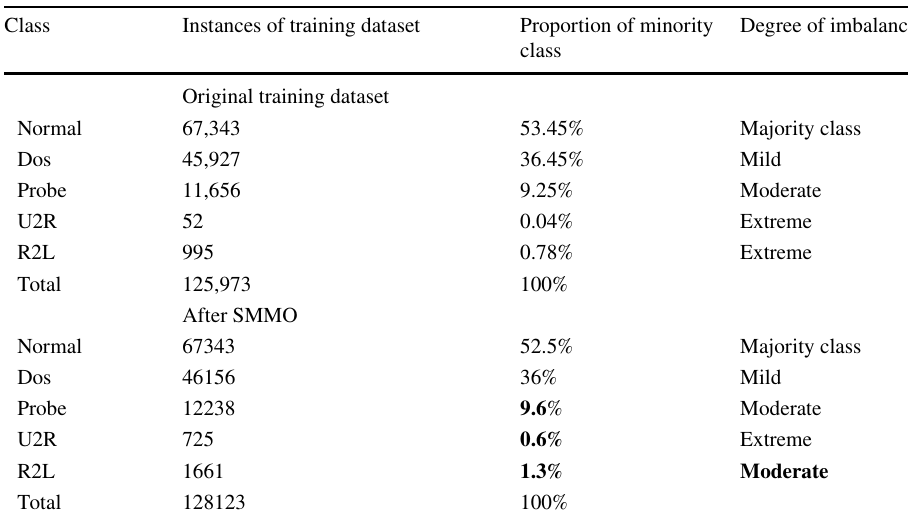
Table 2 Distribution of instances in NSL-KDD Dataset for each class